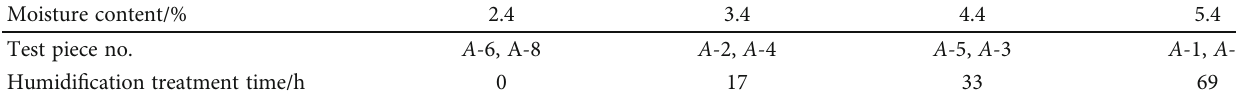
Table 1: Grouping of coal and rock specimens.